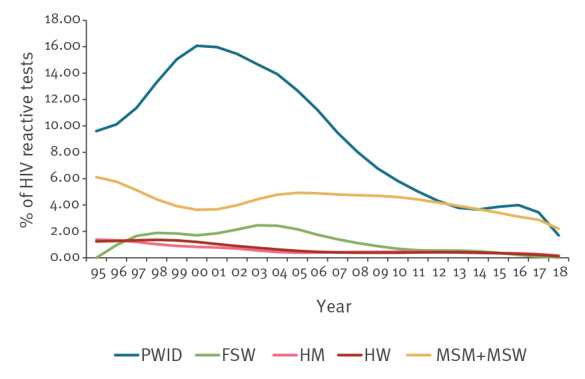
Percentage of HIV reactive tests by transmission group per year, Catalonia, Spain, 1995–2018 (n people tested = 106,992a; n reactive tests = 2,848b)